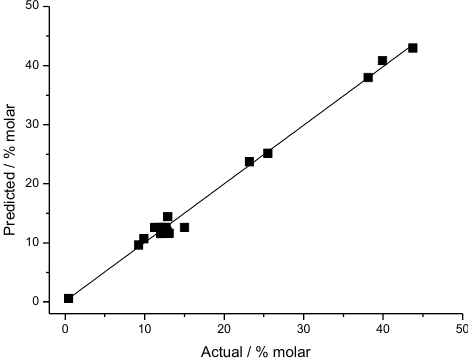
Figure 4. Predicted versus actual values for BETX experimental response.